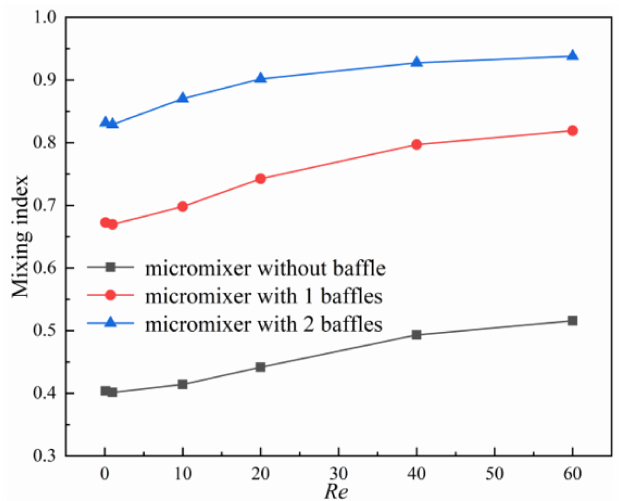
Figure 15. Effect of the number of baffles on mixing